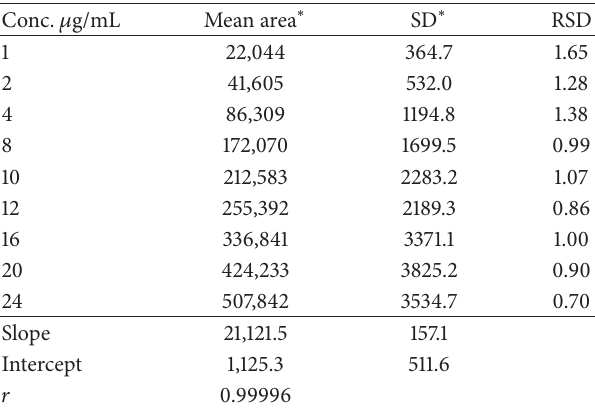
Table 1: Linearity of the present method.